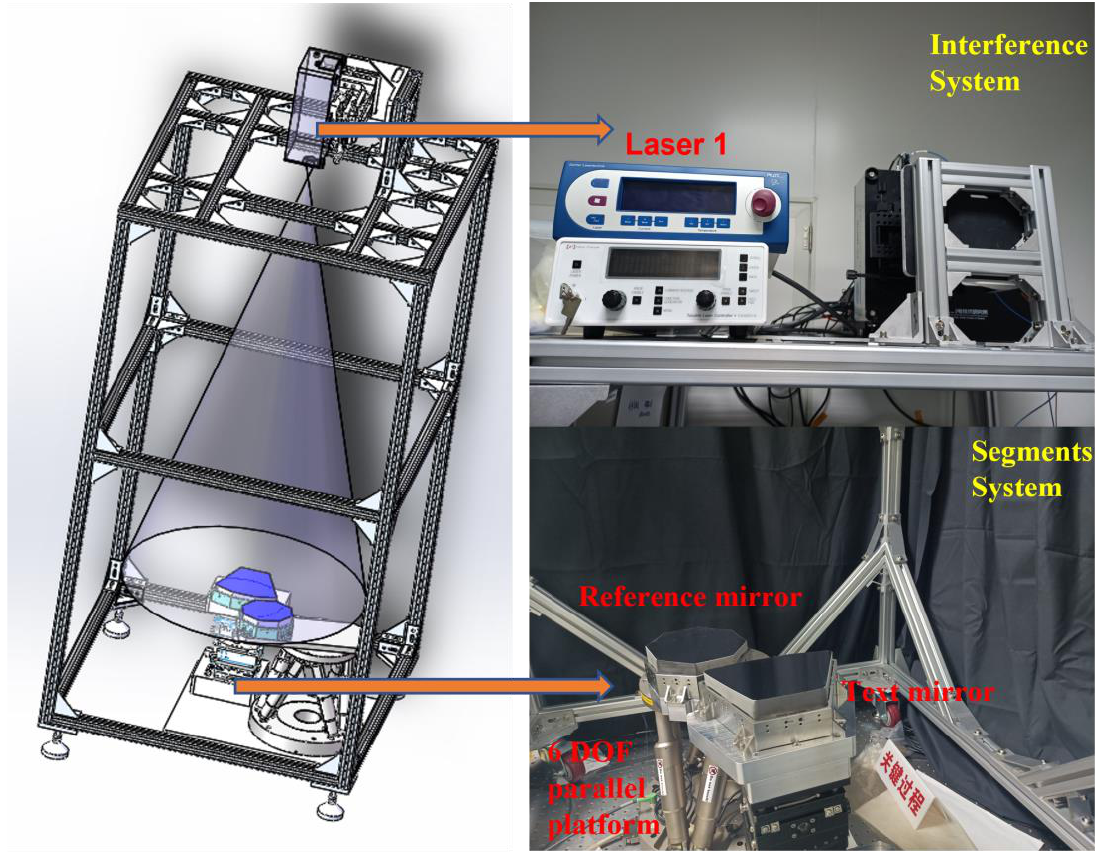
Figure 5. Experimental setup.